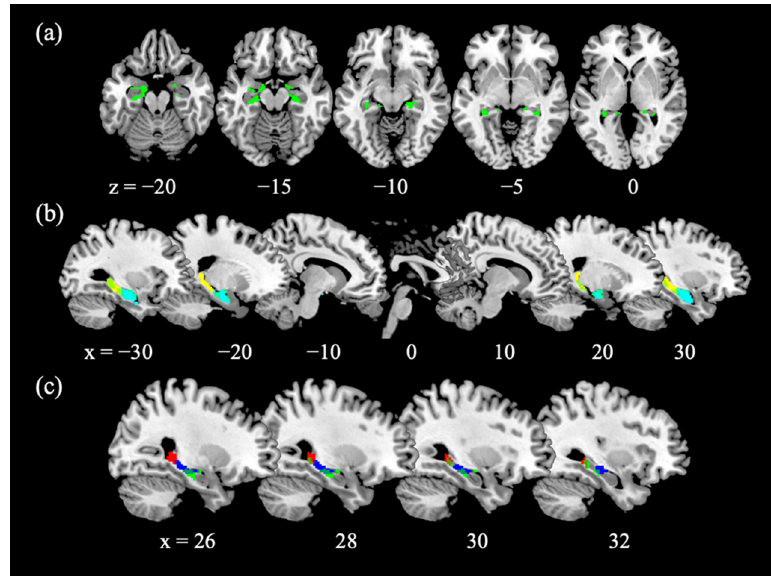
Figure 1. GMV of the hippocampus. ( a ) Age-related decreases in the GMV of bilateral anterior and posterior hippocampi; ( b ) Overlap with anterior hippocampus mask (cyan) and posterior hippocampus mask (yellow) divided at MNI coordinate y= − 22, as defined in Zeidman and Maguire [30]; ( c ) Overlap with the functional cluster in the anterior hippocampus identified from a regression of SS > GS with age (blue; Figure 2a) and with the functional cluster in the posterior hippocampus identified from a regression of p(Stop) > 0 with age (red; Figure 2a).